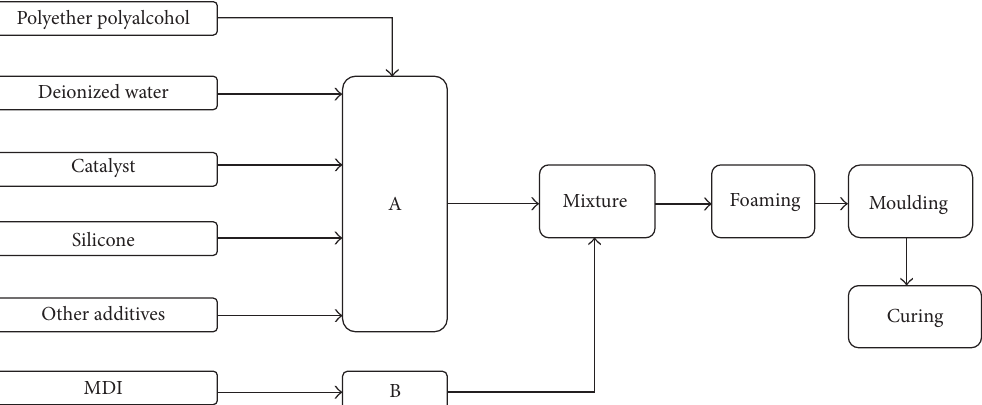
Figure 1: Process for preparing the polyurethane foams.